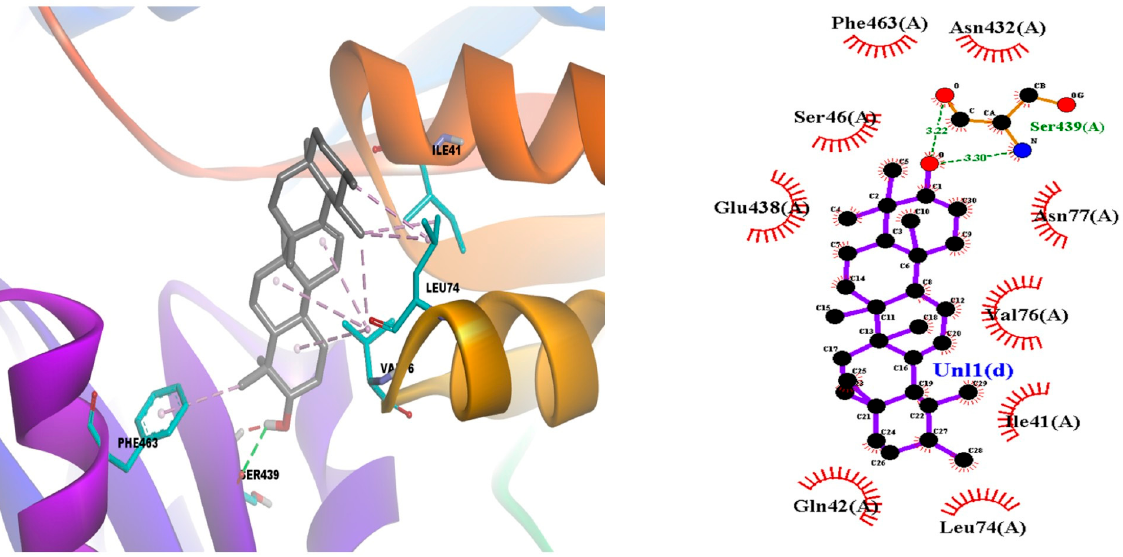
Figure 5. α -Amiryn compound interaction of allosteric binding sites of target proteins pyruvate kinase (PDB: 1PKL).